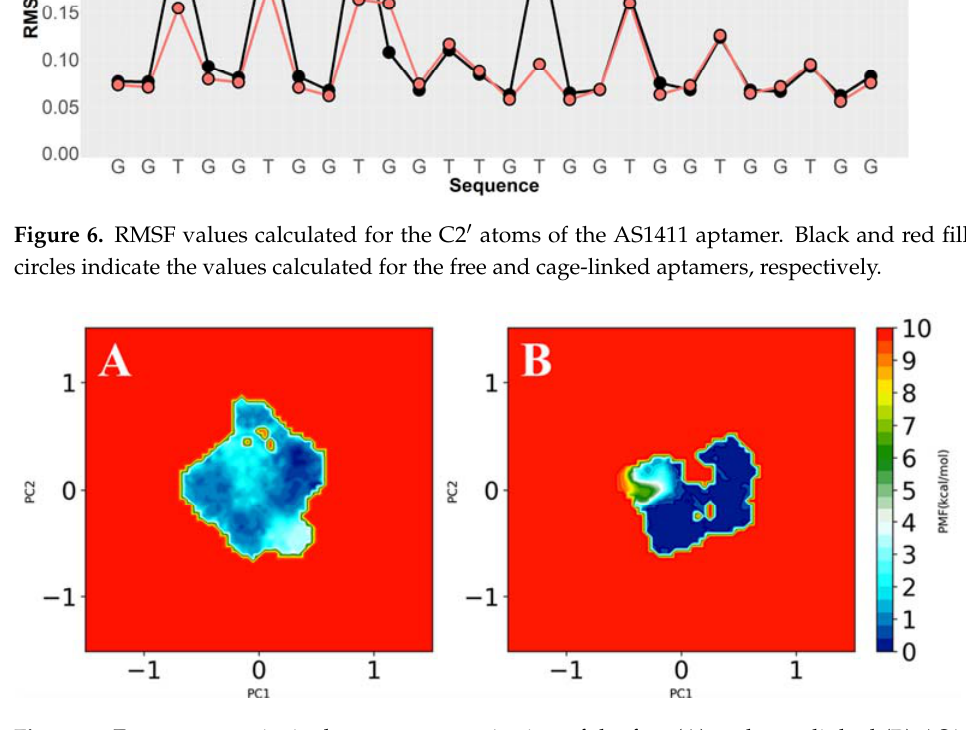
Figure 7. Free energy principal component projection of the free ( A ) and cage-linked ( B ) AS1411 aptamers.